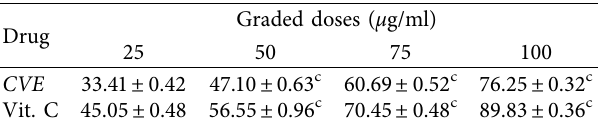
Table 4: In vitro DPPH-scavenging activity of 25–100 μ g/ml of CVE and vitamin C.